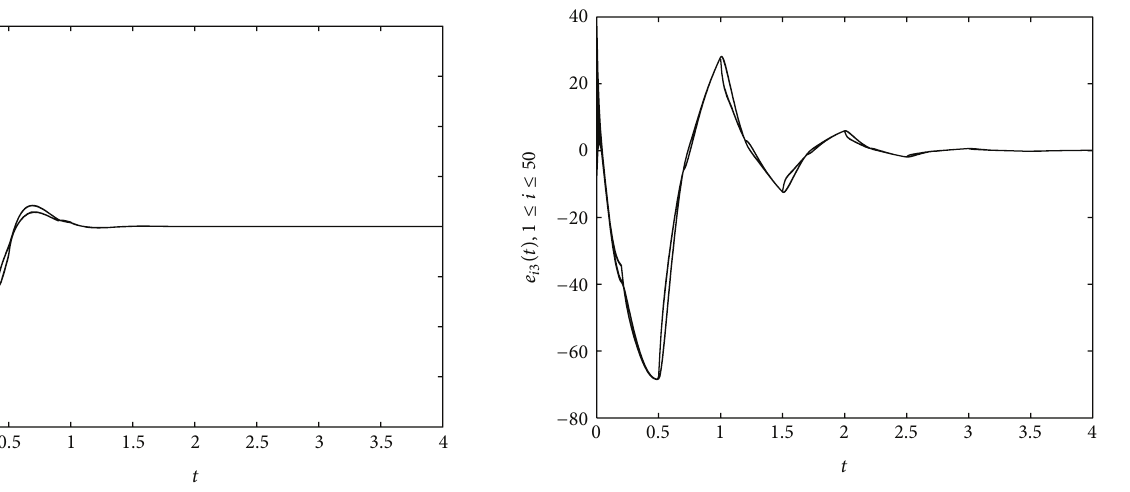
Figure 7: Synchronization errors 𝑒 𝑖 3 , 1 ≤ 𝑖 ≤ 50, with control parameters 𝑘 = 5, 𝑇 = 0 . 5, and 𝜃 = 0 .